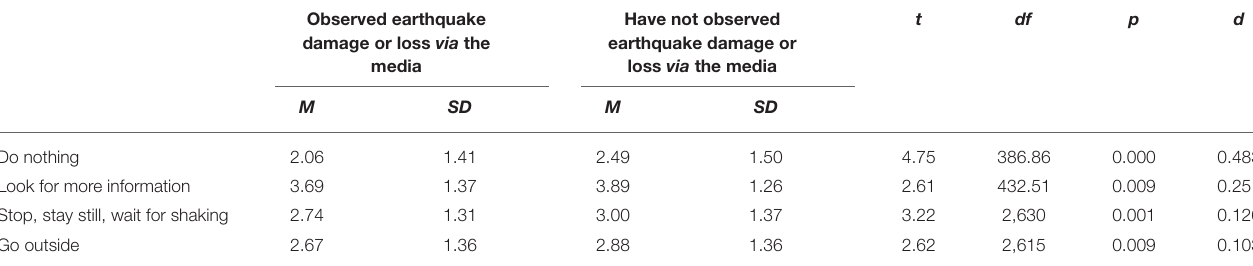
TABLE 3 | Results of independent samples t -tests comparing mean intentions scores for a range of actions between those who have and have not observed earthquake damage or loss via the media. Observed earthquake damage or loss via